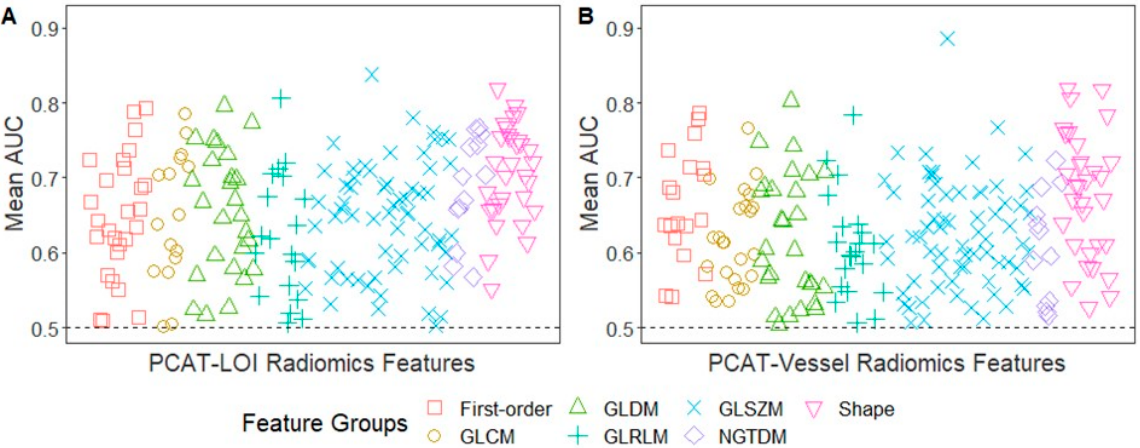
Figure 4. Univariate CCTA-radiomics feature analysis for predicting IVOCT-MC. Manhattan plot of PCAT-LOI ( A ) and PCAT-Vessel ( B ) of the mean AUCs for the identification of coronary vessels with IVOCT-MC. The number of radiomic features with AUC > 0.5 for identification of coronary vessels with IVOCT-MC was 195/293 (66.6%) for PCAT-LOI and 203/341 (59.5%) for PCAT-Vessel. Of 195 radiomic features with AUC > 0.5 from the PCAT-LOI, 31 (15.9%) were shape features, 27 (13.9%) were first-order statistics, and 137 (70.3%) were texture-based features (GLCM: 16, GLDM: 26, GLRLM: 19, GLSZM: 63, NGTDM: 13). Of 203 radiomic features from the PCAT-Vessel, 32 (15.8%) were shape features, 19 (9.4%) were first-order statistics, and 152 (74.9%) were texture-based features (GLCM: 24, GLDM: 28, GLRLM: 21, GLSZM: 67, NGTDM: 12).